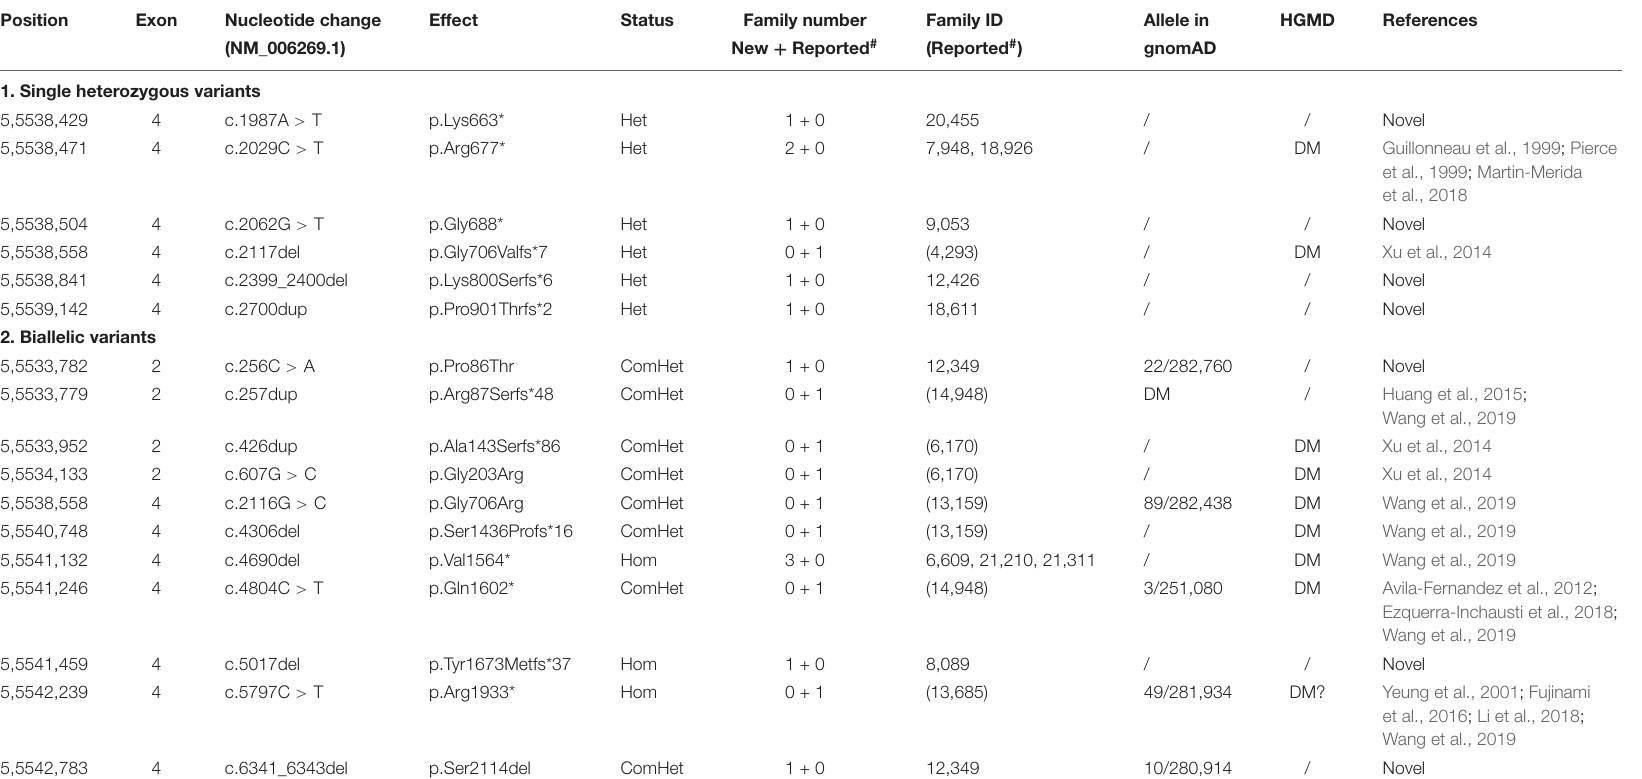
TABLE 1 | Potential pathogenic variants associated with retinitis pigmentosa (RP) in our